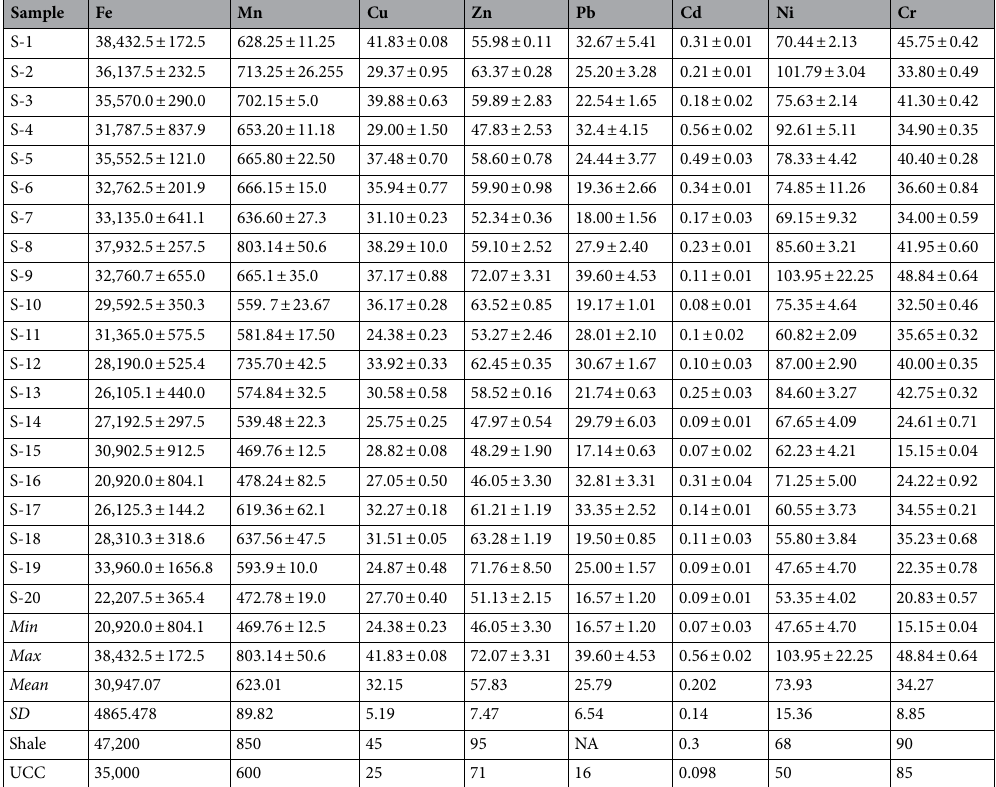
Table 4. Distribution of the trace metal concentrations (µg g -1 ) in the Sundarbans mangrove soils. Min . minimum, Max . maximum, SD standard deviation, UCC upper continental